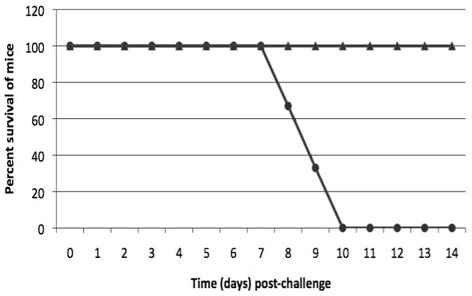
Protective efficacy of LVSΔ1423/1422 against IN challenge of mice with LVS.Groups of BALB/c mice were injected with PBS (•), or inoculated with 6.1×103 CFU/mouse of LVS Δ1423/1422 (▴). Six weeks PI, the mice were challenged IN with 1.4×105 CFU/mouse of LVS, and the mice were monitored for 4 weeks. No mice died or were symptomatic by 10 days post-challenge. The P value for animal survival after 10 days post-challenge was <0.001.